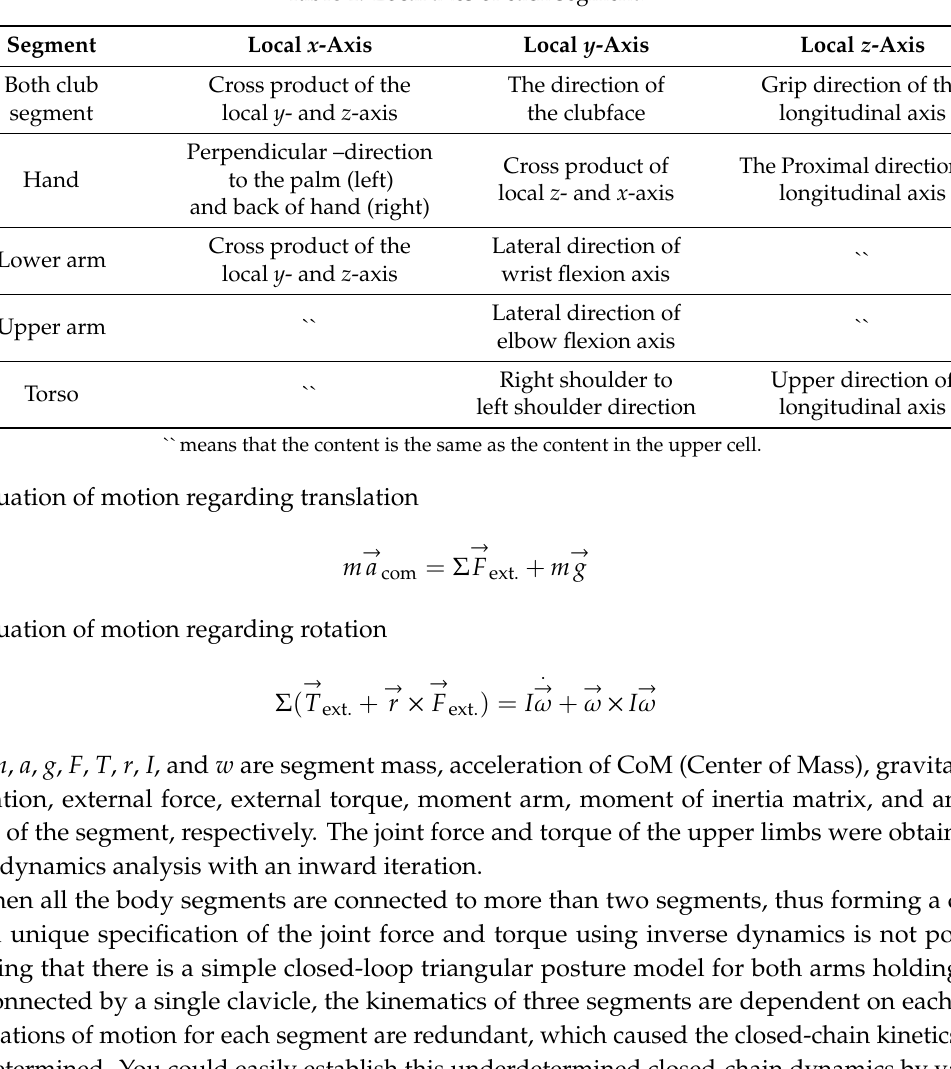
Table 1. Local axes of each